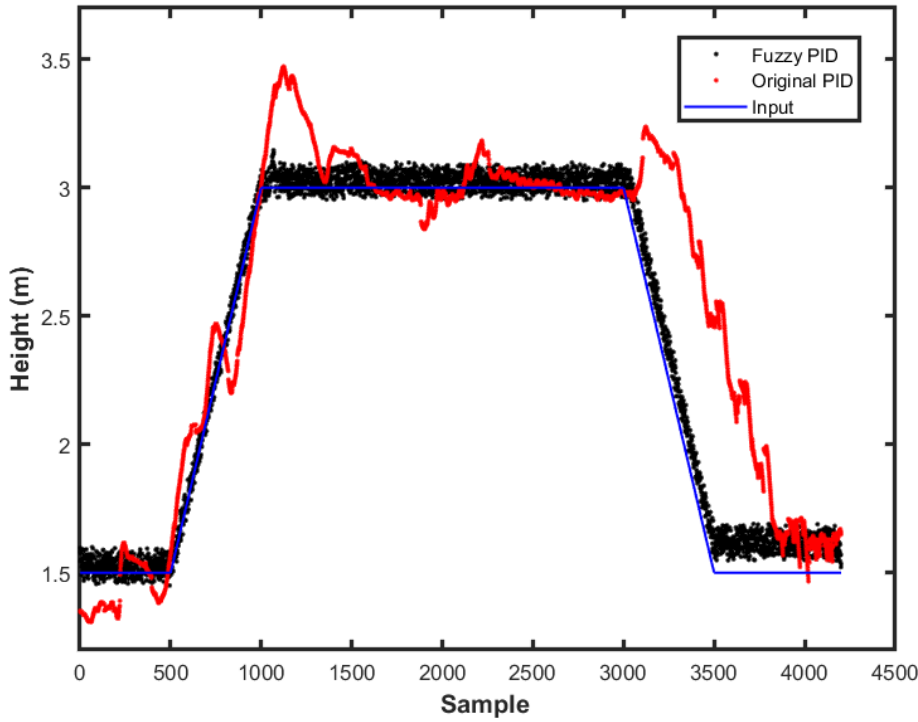
Figure 21. Height response for the practical